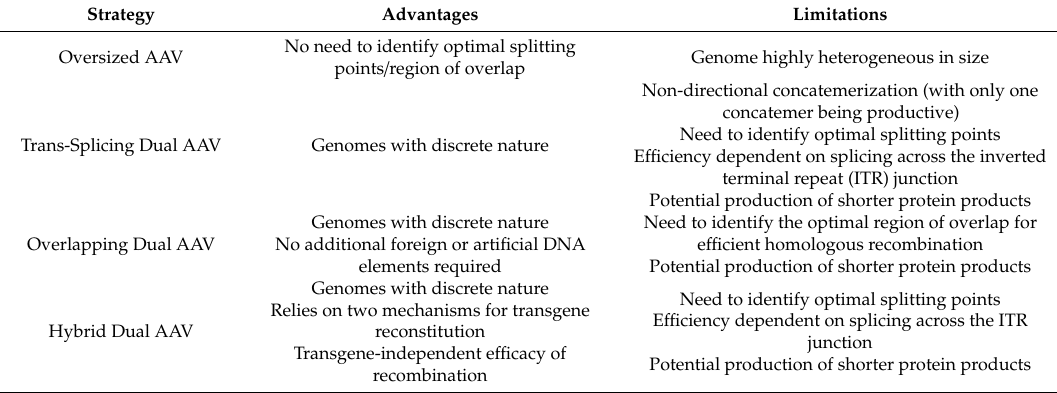
Table 1. Adeno-associated viral (AAV) vector-based strategies for large gene delivery.